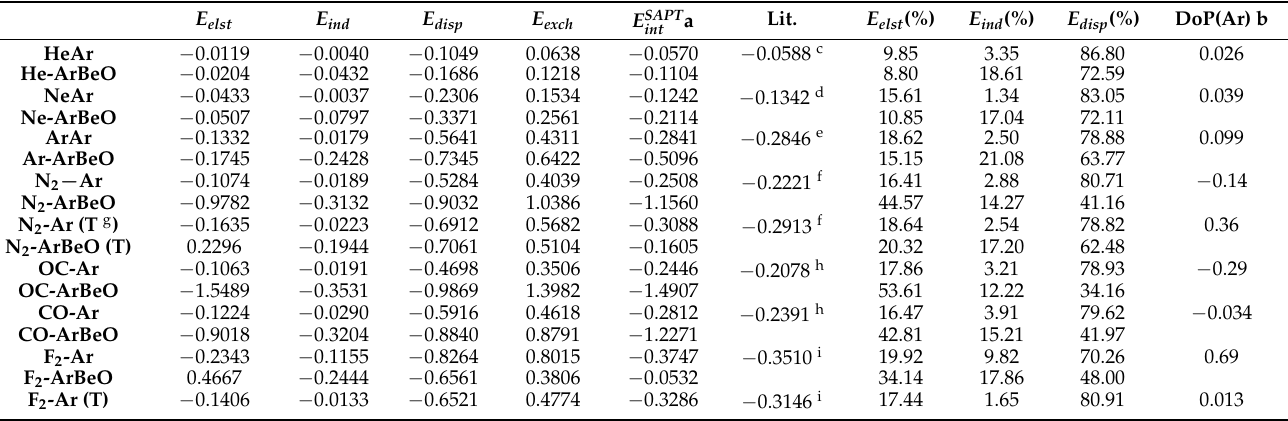
Table 1. SAPT analysis (kcal mol − 1 ) of the L Ar(dissociation limits: L + Ar) and L -ArBeO(dissociation limits: L + ArBeO) (see Figure 2) performed with the aVTZ/mbf basis set. E elst (%), E ind (%), and E disp (%) are the percentage contributions, respectively, of | E elst |, | E ind |, and | E disp | to (| E elst |+ | E ind | + | E disp